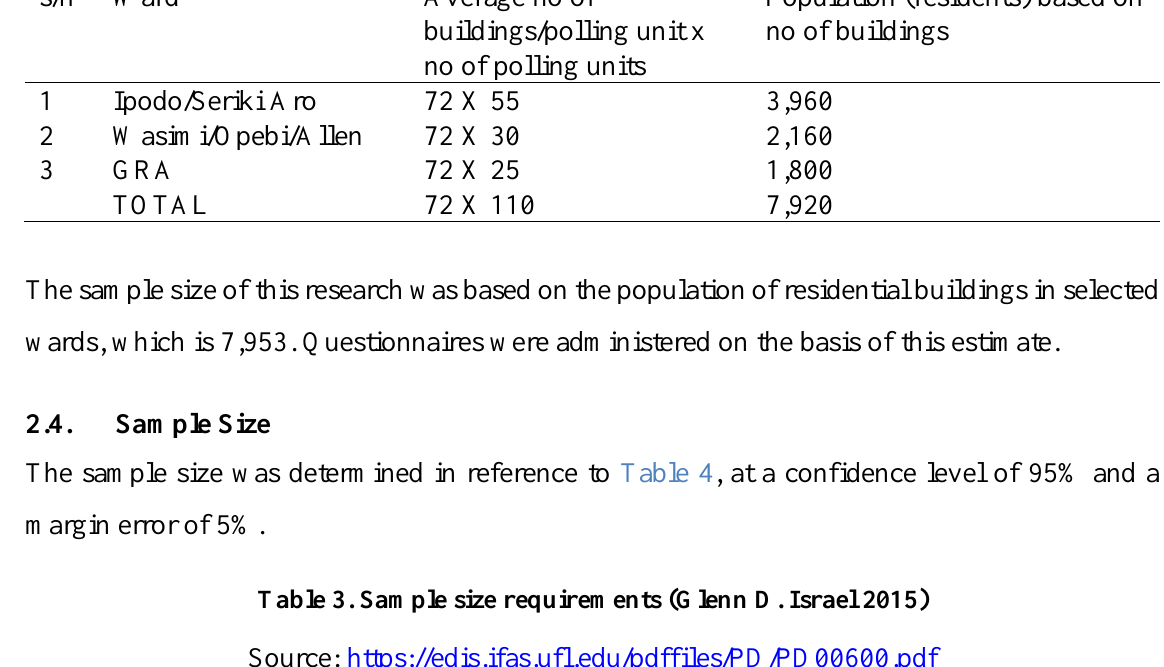
Table 2. Selected wards. Source: Independent National Electoral Commission (2000). s/n